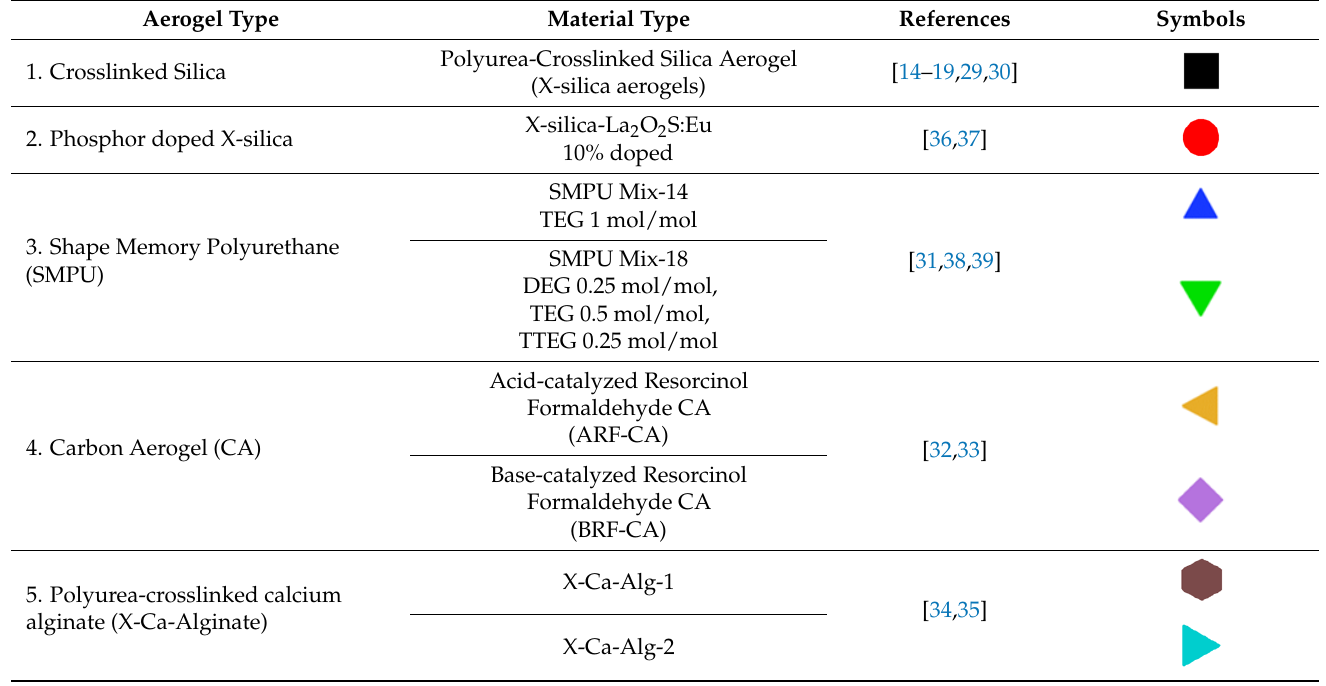
Table 1. Aerogel types used in this study.